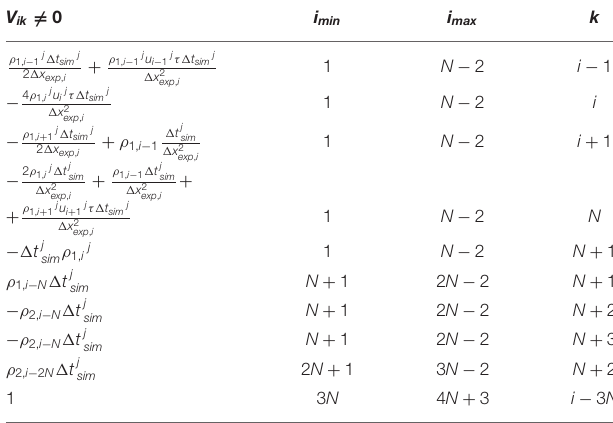
TABLE 1 | The evolution matrix F . F ik 6= 0